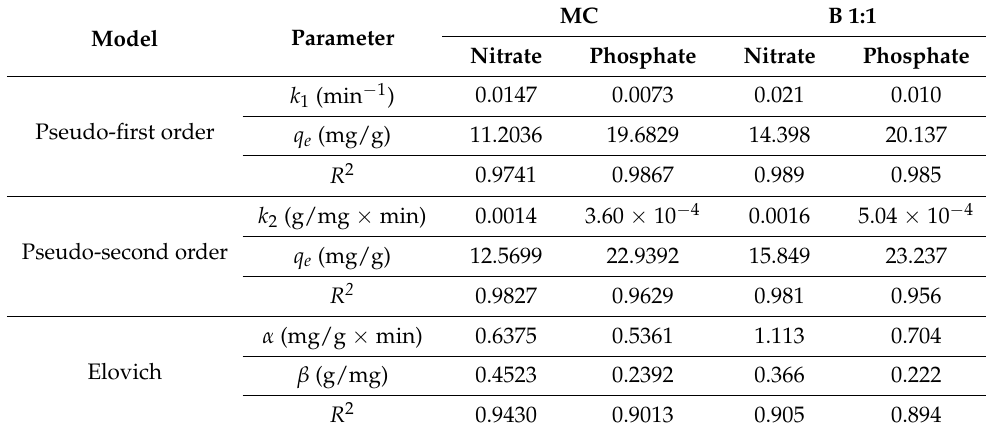
Table 4. Kinetic Model Adjustment